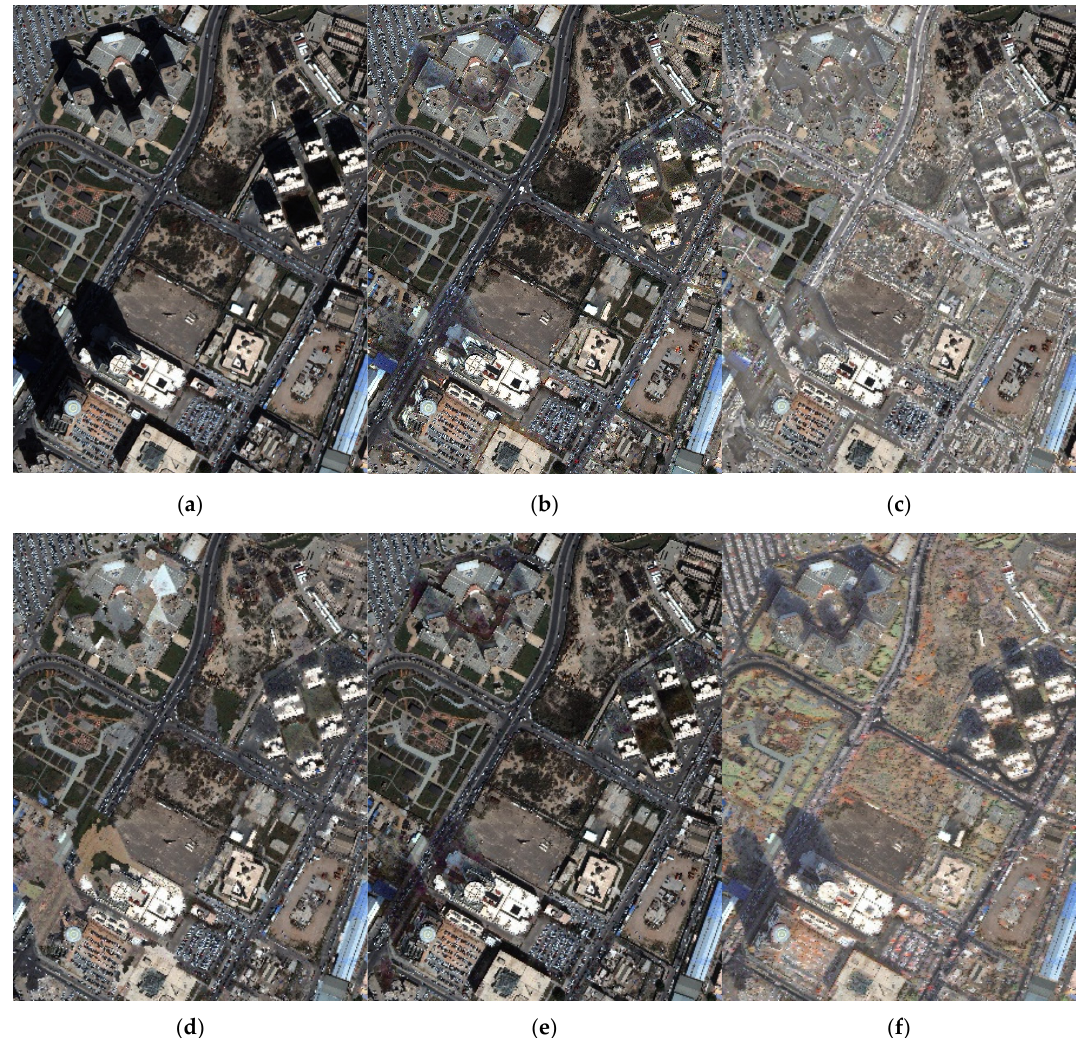
Figure 16. Shadow removal comparison of experimental data 1: ( a ) original image; ( b ) proposed; ( c ) Shor’s; ( d ) Guo’s; ( e ) Yu’s; and ( f ) Bauer’s.